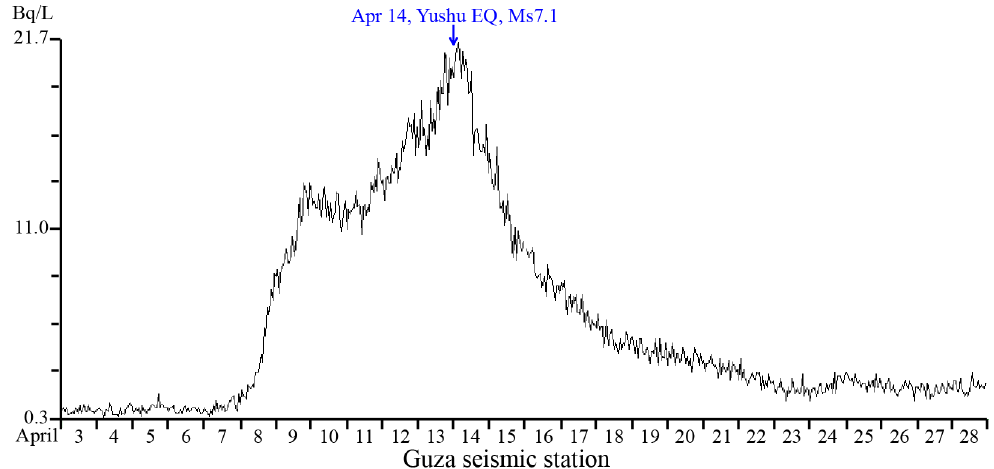
Figure 3. The gas radon anomaly curve before Yushu earthquake at Guza seismic station, and the locations of this station shows in Figure 1a, the black triangle [Li et al.